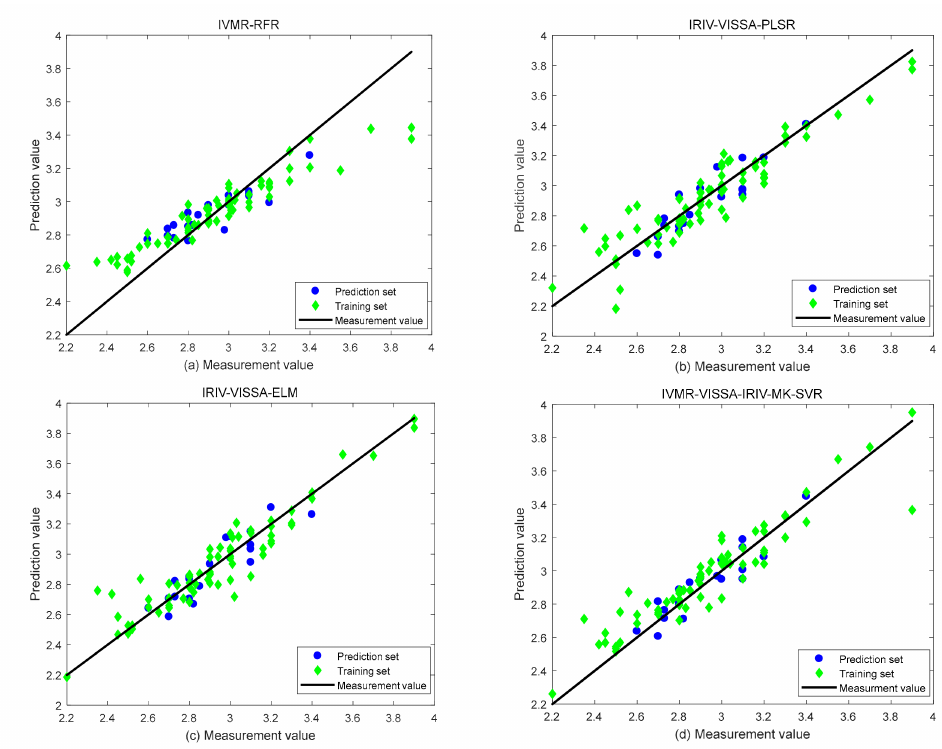
Figure 15. Regression graphs of the optimal prediction results of the four regression models. ( a ) IVMR-RFR; ( b ) IRIV-VISSA-PLSR; ( c ) IRIV-VISSA-ELM; ( d )